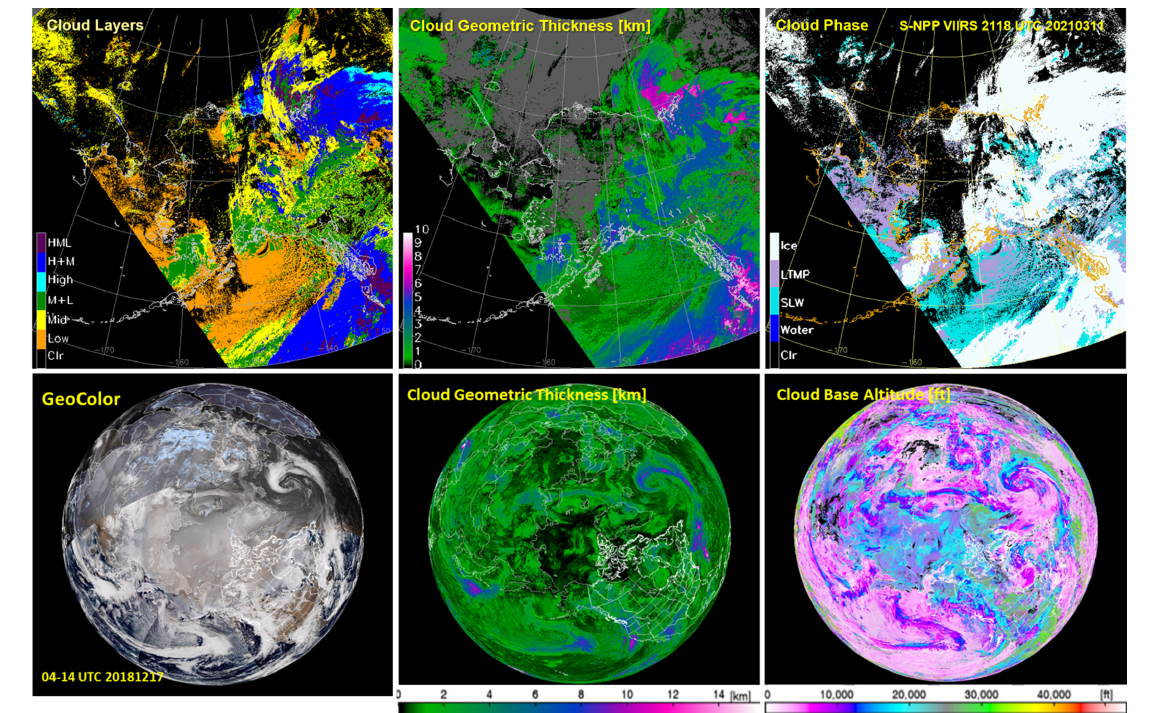
Figure 3. VIIRS cloud product examples. The upper panels show Cloud Layers, Cloud Geometric Thickness (CGT), and Cloud Phase imagery over Alaska ( upper panels ). The bottom panels show global CGT and Cloud Base Altitude (in feet for aviation users) together with VIIRS GeoColor over the Northern Hemisphere as displayed on CIRA’s SLIDER website.